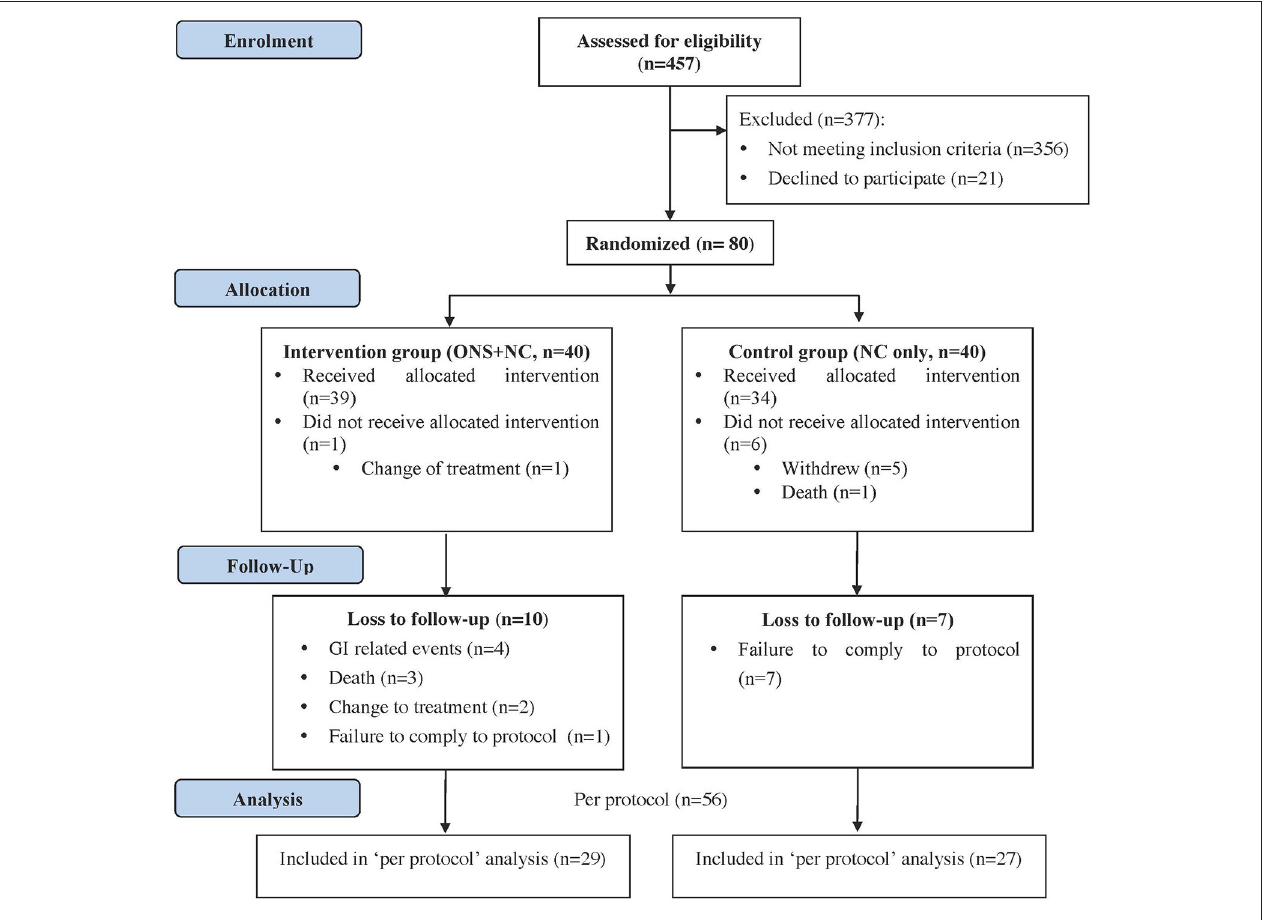
FIGURE 1 | Study flow